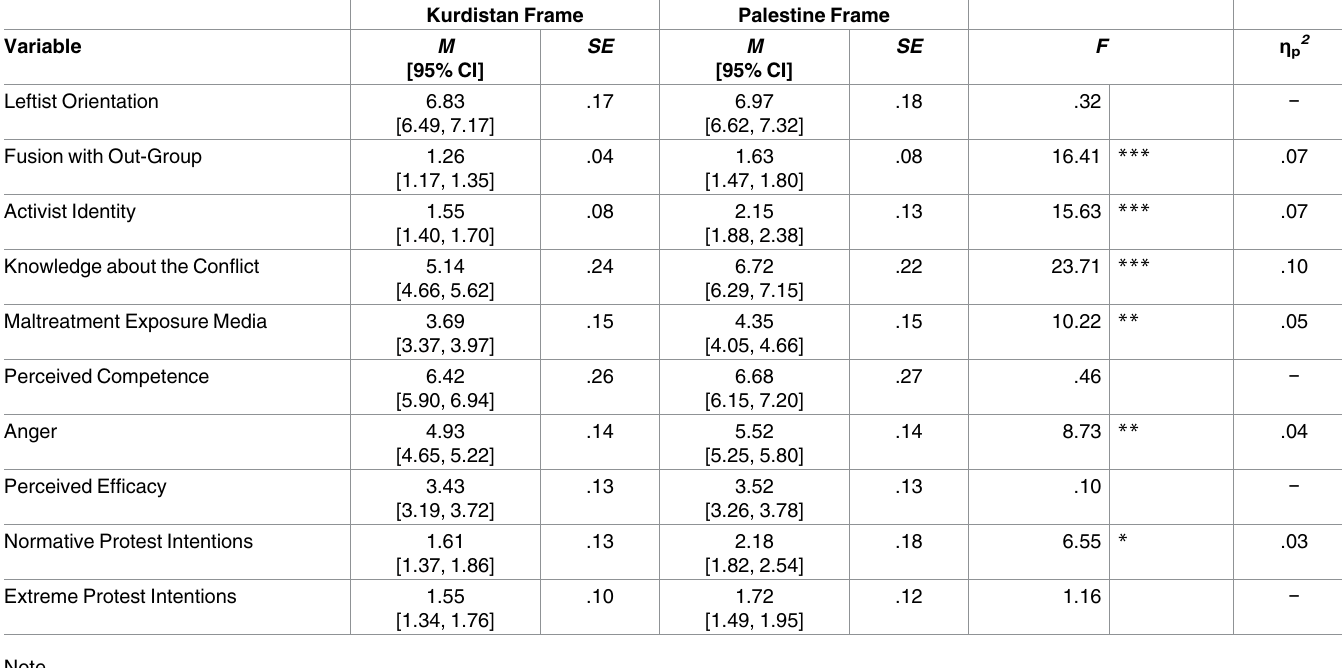
Table 2. Between-group differences for the framing manipulation in Study 2 are